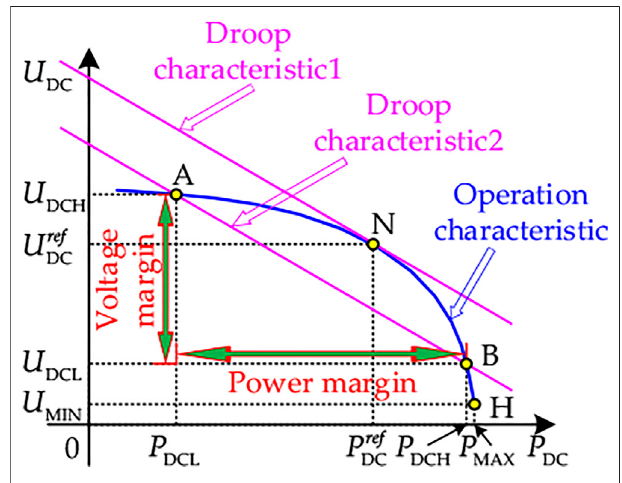
FIGURE 2 | Characteristic curves of U – P